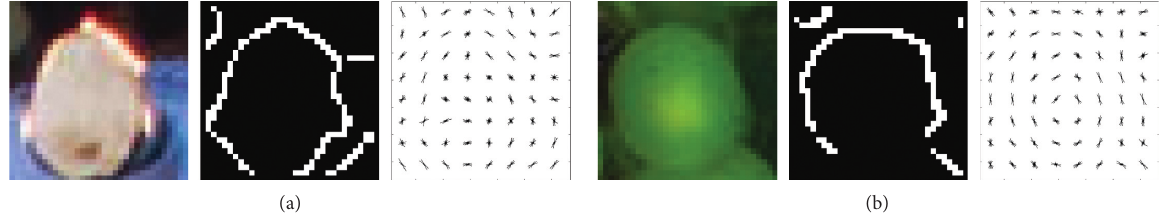
Figure 3: Comparison of head (three images in (a)) and grape images (three images in (b)). For each category, we provide an original RGB image, an image obtained by filtering of the RGB image using the Canny edge detector [33], and gradients obtained using a HOG descriptor [26], respectively.